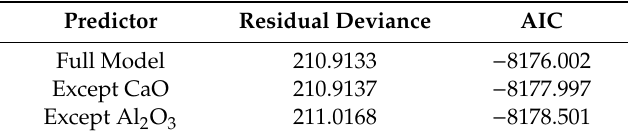
Table 4. Residual Deviances and Akaike Information Criterion (AIC) values corresponding to the redundant Predictors for plant